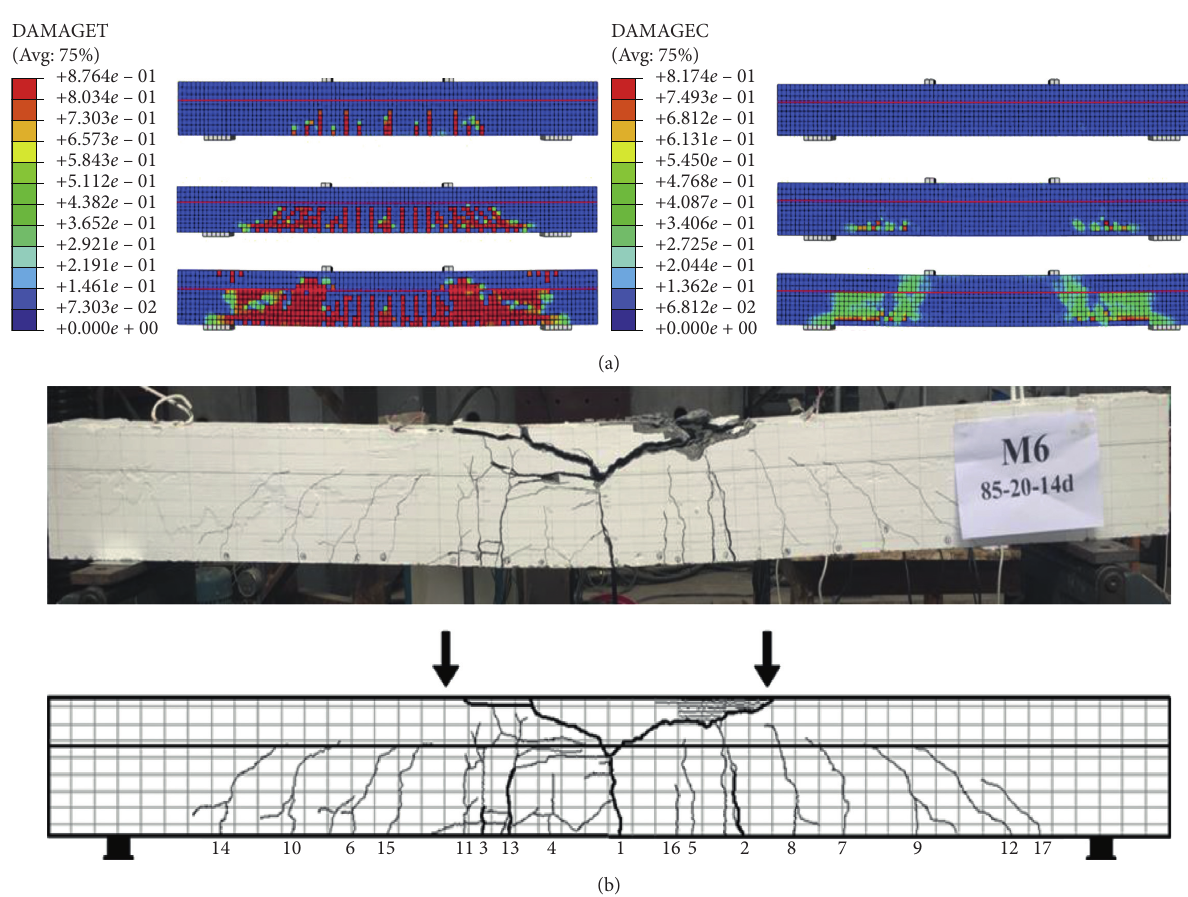
Figure 3: Comparison of cracks distribution of B1-2. (a) The tensile and compressive damage nephogram from the simulation.(b) Experimental